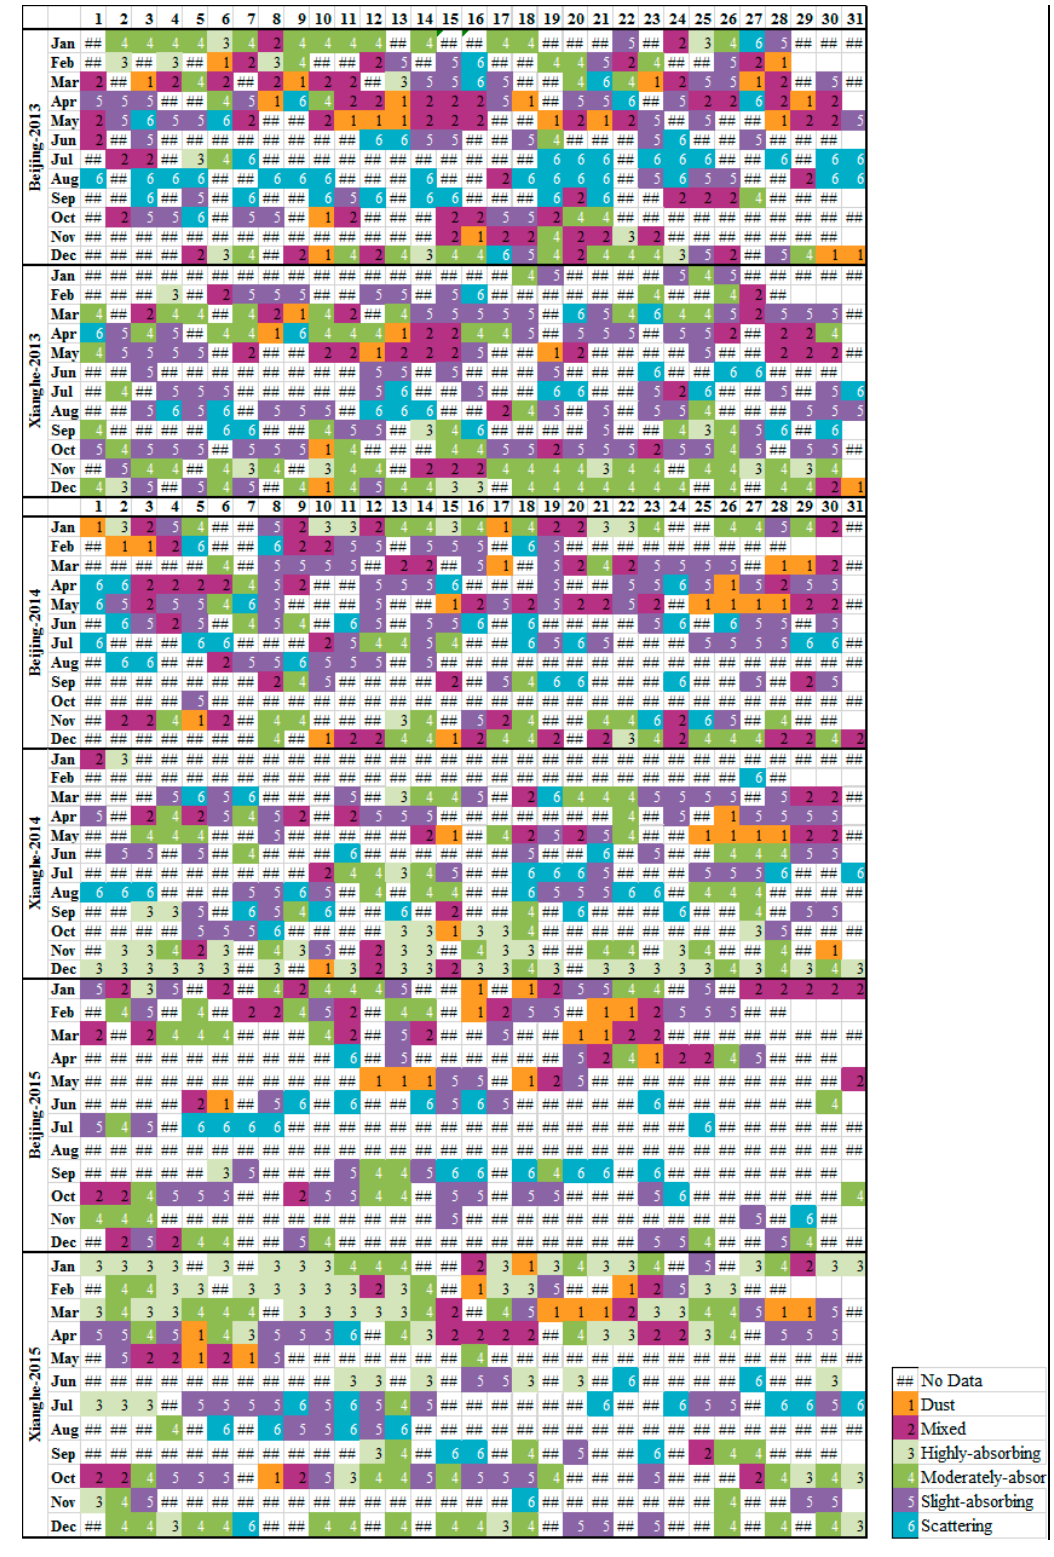
Figure 9. The recorded days of aerosol types in 2013–2015.